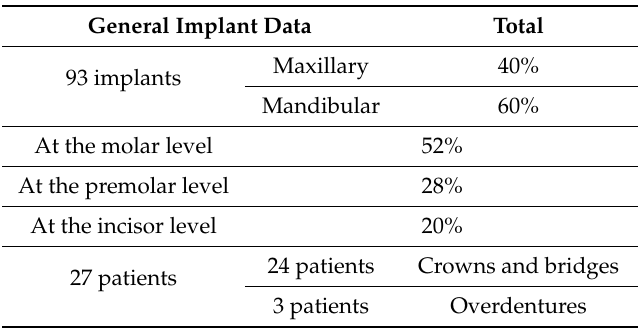
Table 1. General implant data.